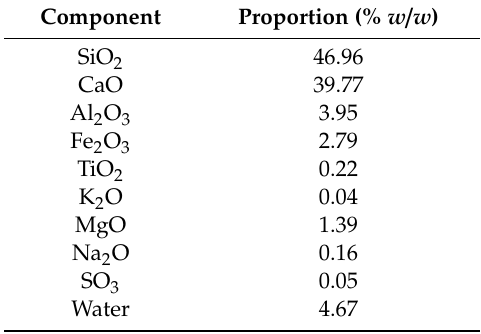
Table 1. Chemicalcompositionofthewollastoniteingredientsonweightbasis. (DatafromHassani et al. Table 1. Chemical composition of the wollastonite ingredients on weight basis. (Data from Hassani et al. [35].